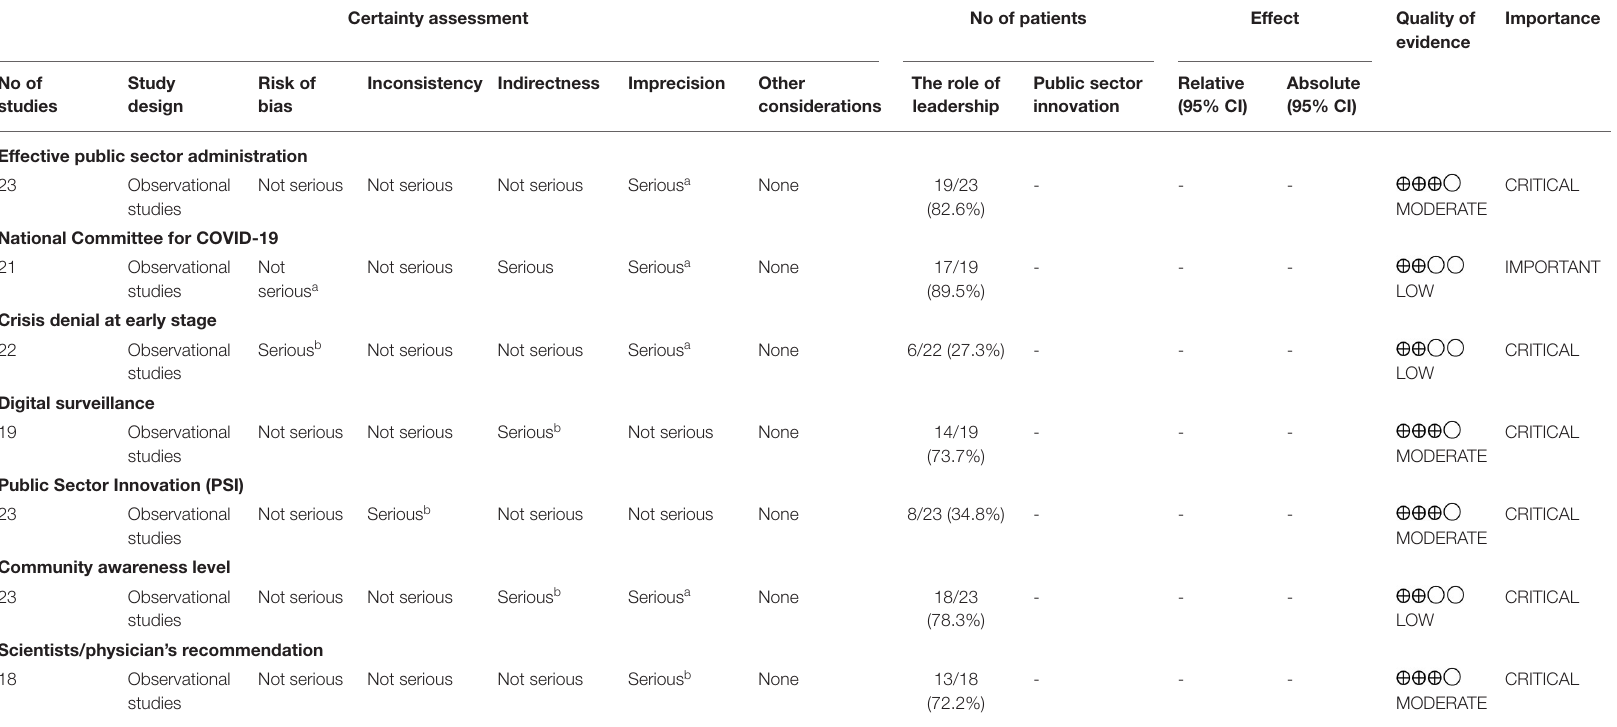
TABLE 1 | Assessment of the quality of the included